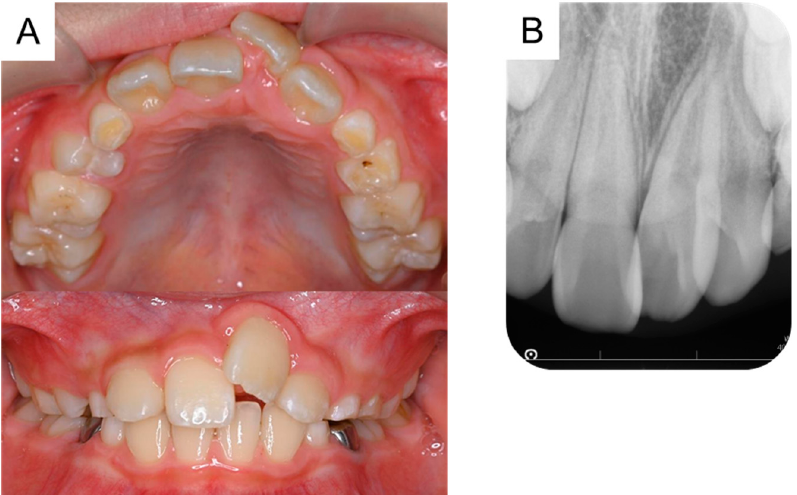
Figure 7. Intraoral photographs at regular checkups. ( A ) Intraoral photograph and ( B ) periapical radiograph obtained in the postoperative period at the age of 9 years and 7 months.